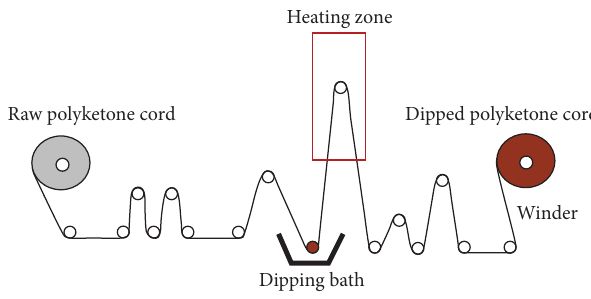
Figure 1: Schematics of the primer dipping process.